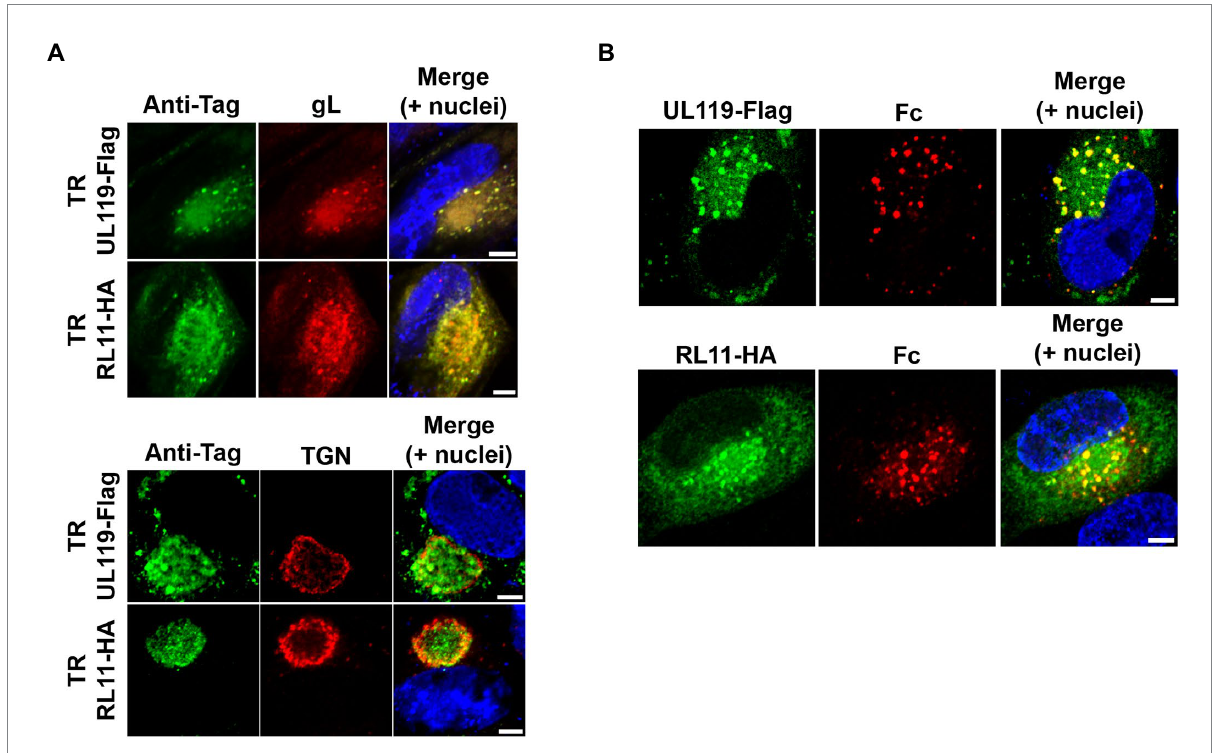
FIGURE 1 gp68 and gp34 localize within the viral assembly complex in HCMV-infected cells and colocalize with human Fc. (A) HFF-1 cells were infected with TR- UL119 Flag and TR- RL11 HA (top and bottom rows, of the two panels, respectively). 5 d.p.i. cells were fixed, permeabilized, and stained. gp68 and gp34 (green color) were detected with anti-tag antibodies. Envelope glycoprotein gL and trans-Golgi network protein TGN46 were stained with antibodies (red color). Z-stacks were collected with a confocal microscope. Representative single confocal slices of each sample are shown. Scale bars: 5 μ m. (B) HFF-1 were infected with TR- UL119 Flag or TR- RL11 HA. 2 d.p.i. 6.6 μ g/ml of 649 Dylight-conjugated human IgG Fc fragment was added to the culture media. After 48 h cells were washed, fixed and stained with anti-tag antibodies (green color). Images were collected through confocal microscopy. Single confocal slices of representative pictures are shown. Superimposition of signals from human Fc (Fc, red color), DAPI stained nuclei (blue color), and anti-tags antibodies are shown in the merge panels. Scale bars: 5 μ